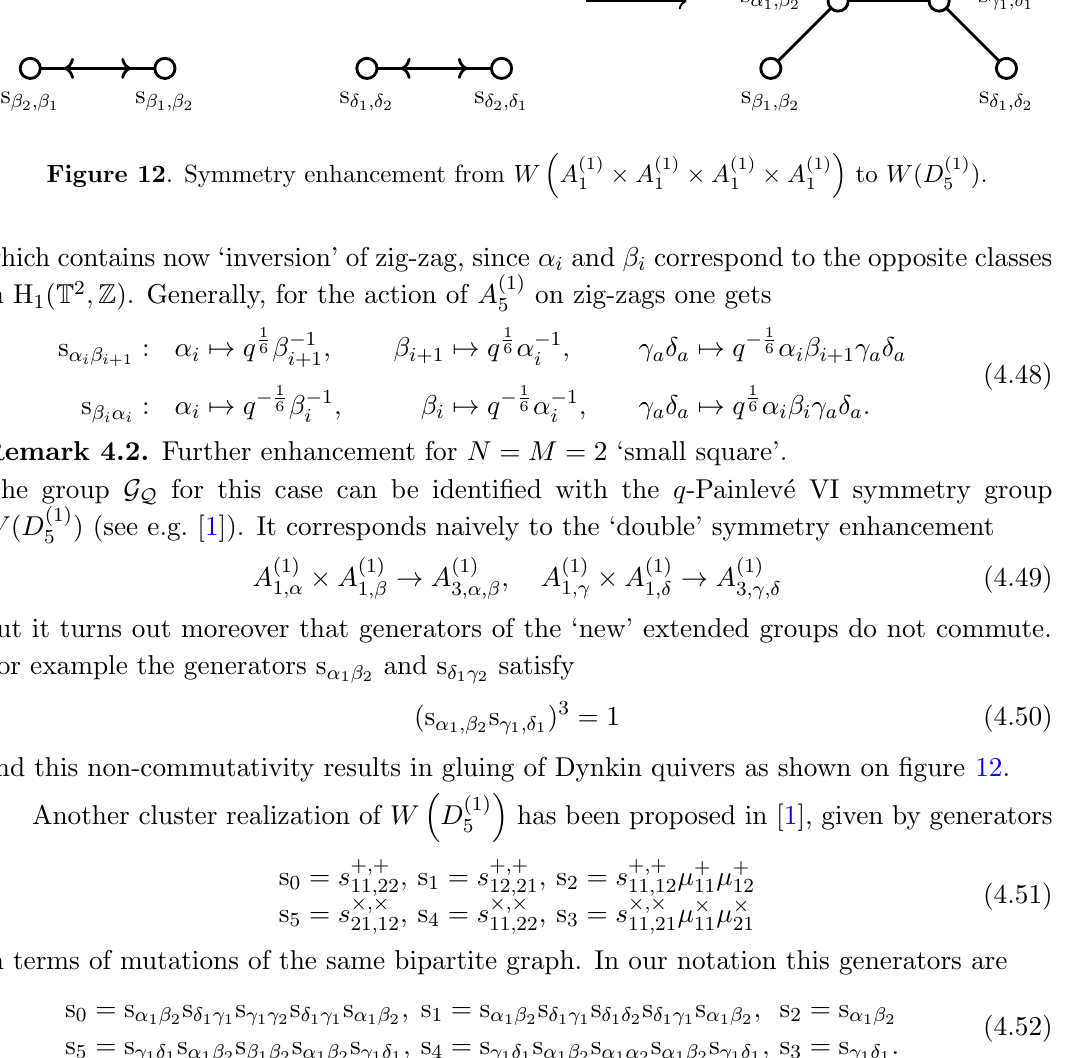
Figure 12 . Symmetry enhancement from W